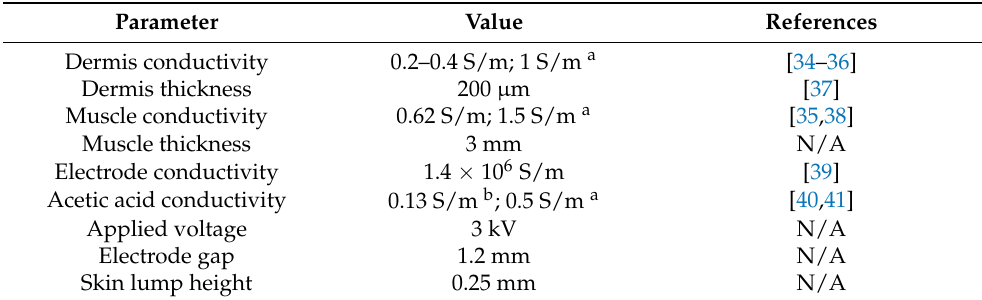
Table 1. Summary of the finite element model parameters.